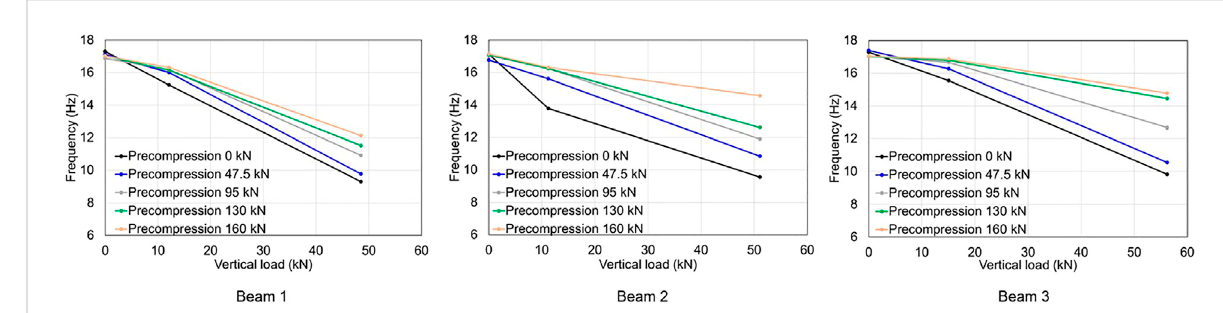
FIGURE 4 Average fundamental frequency as a function of the applied fl exural load and prestressing force.